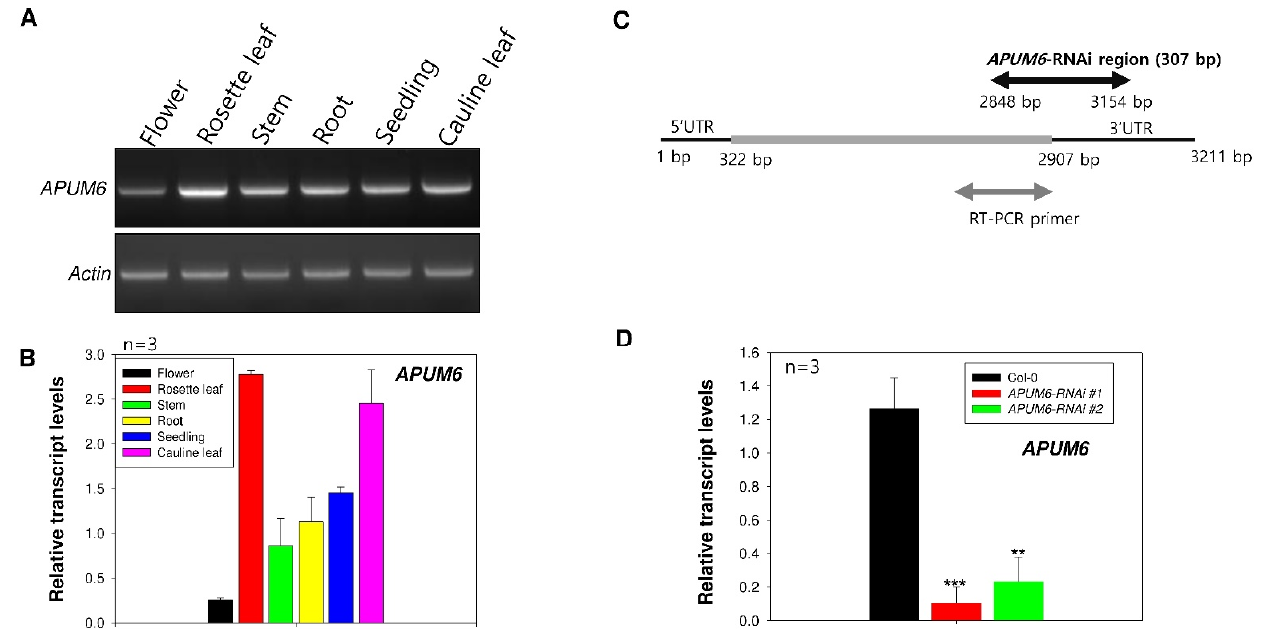
Figure 1. Tissue-specific expression and APUM6 -RNAi transgenic plant analysis. ( A , B ) The ex- pression of APUM6 in the flower, rosette leaf, stem, root, seedling, and cauline leaf determined by semi-quantitative RT-PCR and qRT-PCR with APUM6 -specific primers. Actin was used as an internal control gene. Error bars indicate SD ( n = 3). ( C , D ) Schematic representation of the RNAi target site. A 307 bp partial cDNA fragment of APUM6 was chosen as the target for RNA interference. Two independent T3 RNAi- APUM6 -RNAi transgenic plants were analyzed via qRT-PCR. Bars indicate the standard errors of the mean data ( n = 3), and different letters indicate significant differences (** p < 0.01, *** p < 0.001).